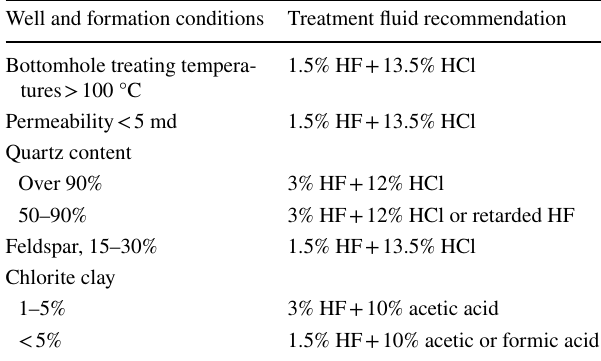
Table 4 Alternate sandstone acid procedures established by Portier et al. (2007)